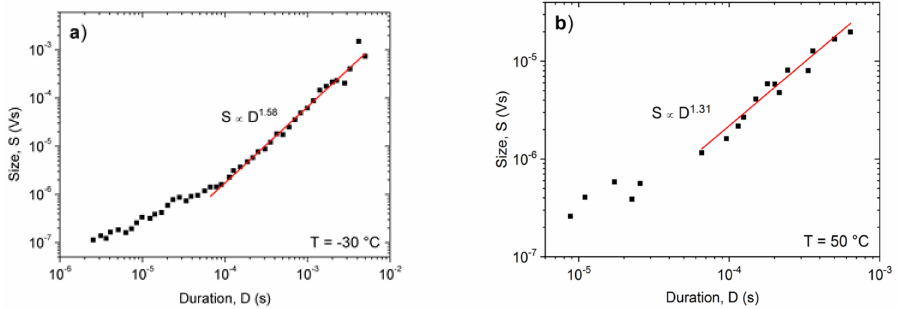
Figure 7. S versus D function at − 30 ◦ C ( a ) and 50 ◦ C ( b ).